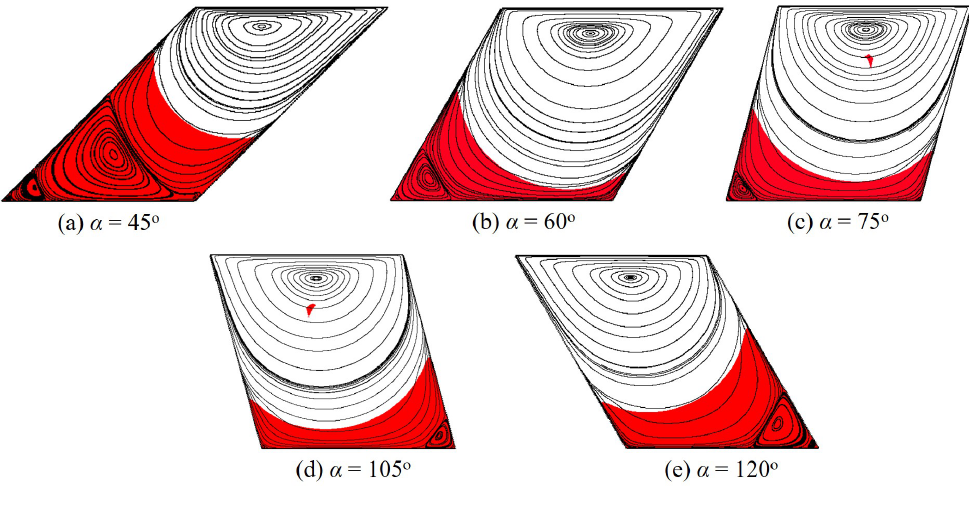
Figure 15. Flow morphology of the polymer gel in skewed cavities with different α at Od = 1